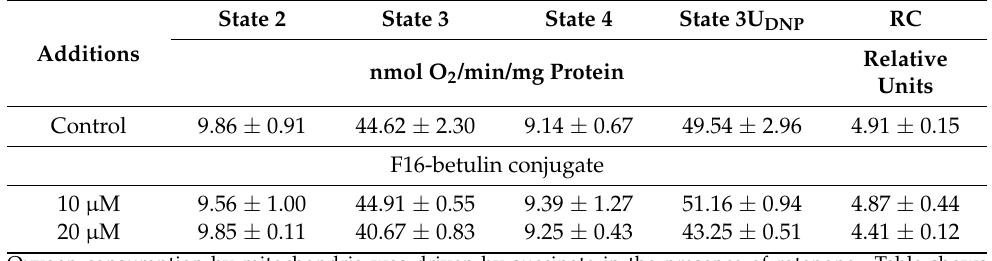
Table 2. Effect of F16-betulin on oxygen consumption by rat liver mitochondria fueled by succinate.